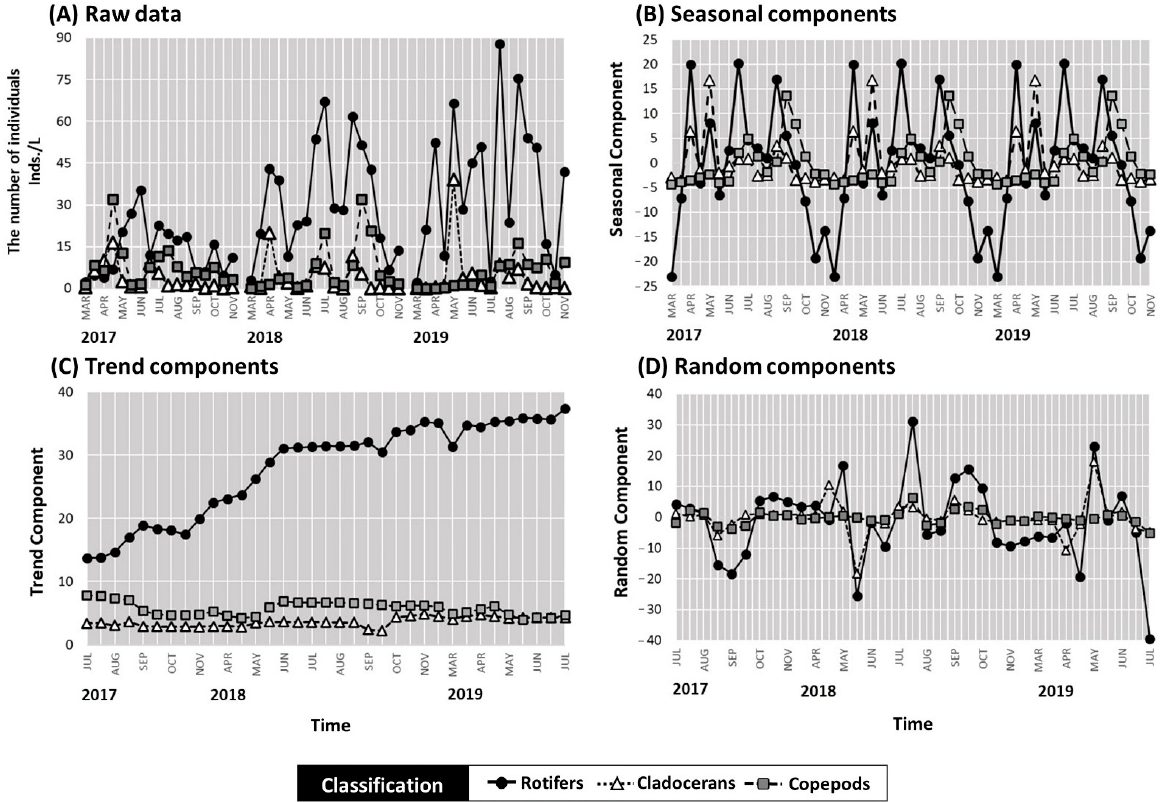
Figure 3. Inter-annual changes (2017–2019) in the number of zooplankton individuals by taxon ( A ) and patterns of change in the seasonal ( B ), trend ( C ), and random ( D ) components derived from the time series of rotifers, cladocerans, and copepods in Daecheong Lake.